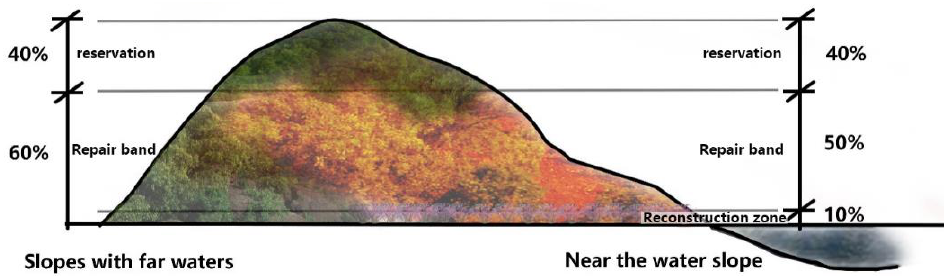
Figure 10. Forest phase update chart.